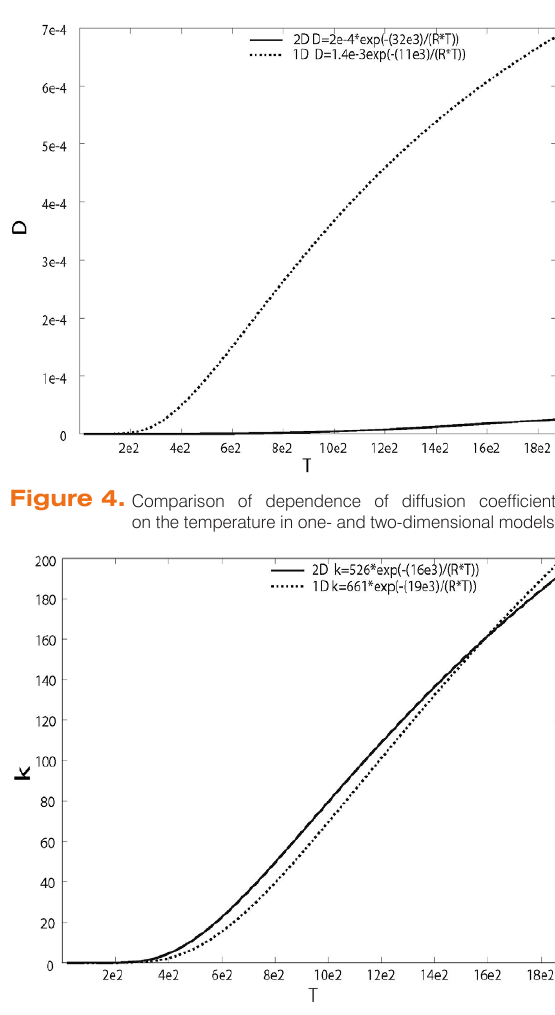
Figure 5. Comparison of dependence of reaction rate coefficients on the temperature in one- and two-dimensional models.